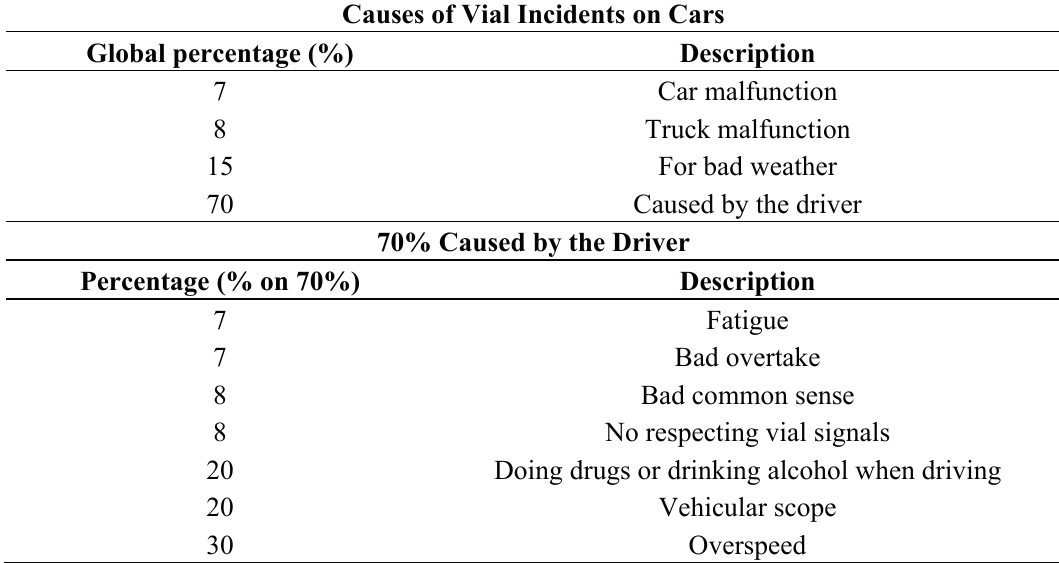
Table 2. Main causes of vial incidents in Mexico in the year 2007. According to Mexican Association of Insurance